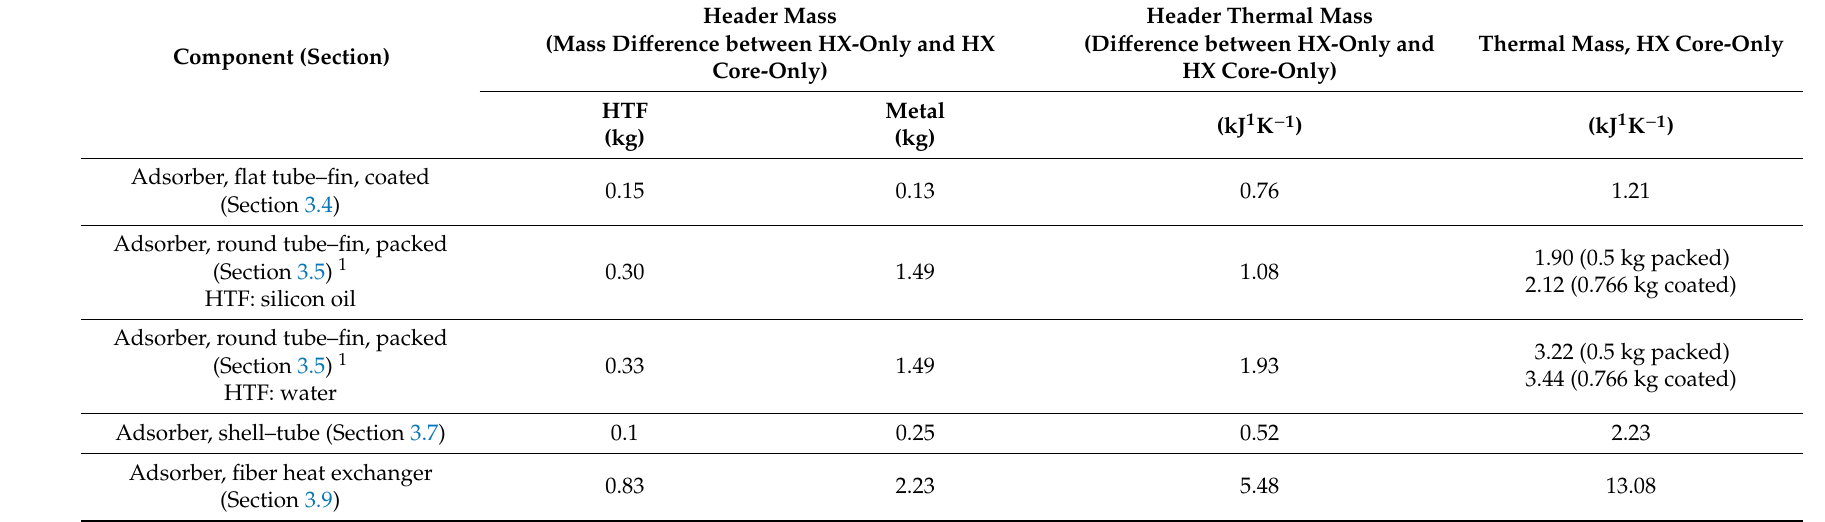
Table 6. Comparison of thermal mass in header with HX